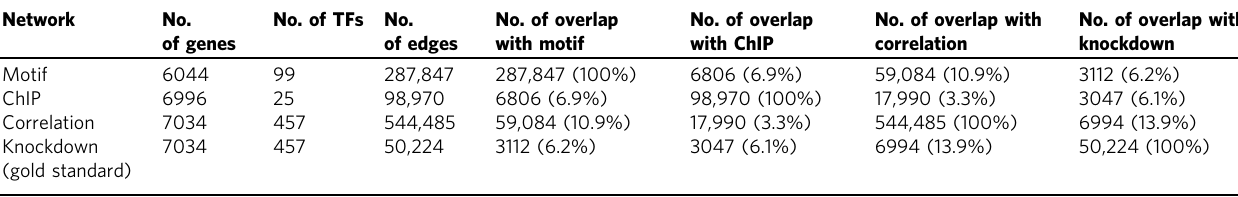
Table 2 Overlap between prior networks and the benchmarking network for Drosophila S2 cell line. Network